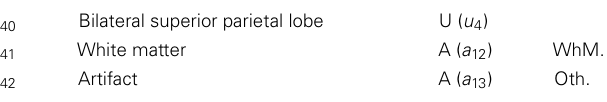
Table 1 | Classification of group-level V = |v 1| ... | v 42 | maps according to the F/A/U